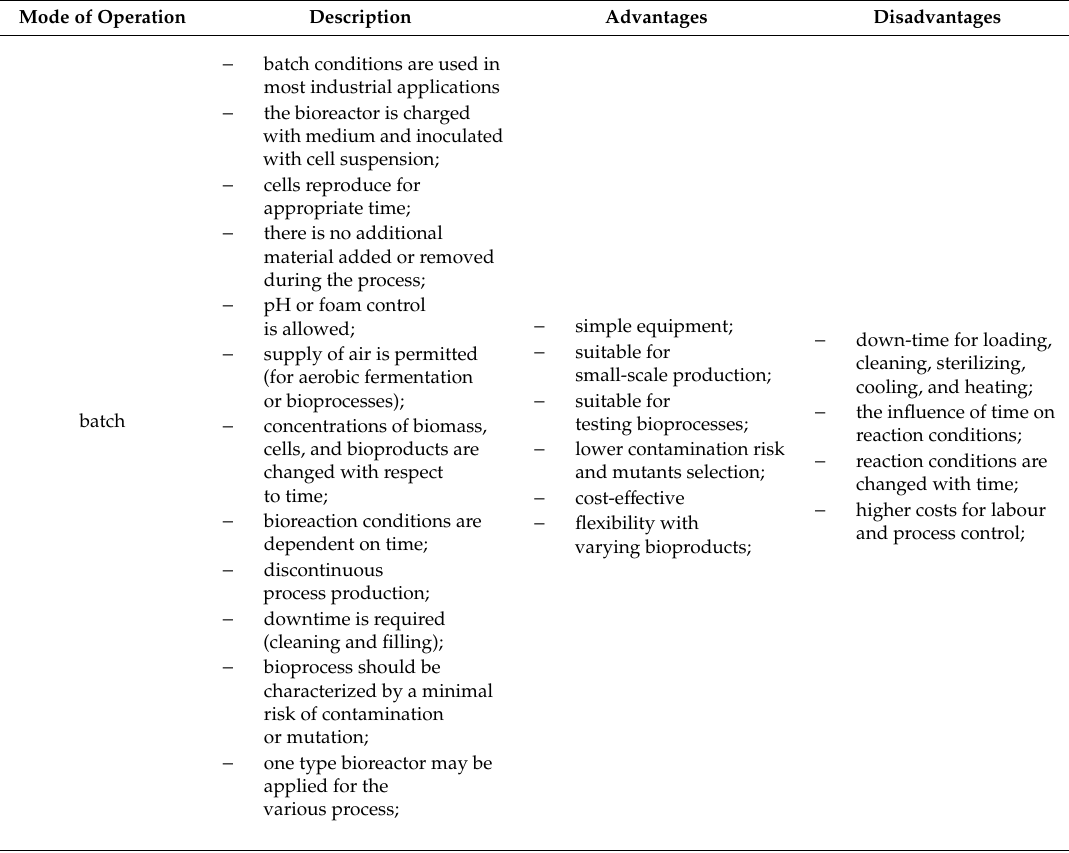
Table 2. Summary of reactor modes and operating variables for various